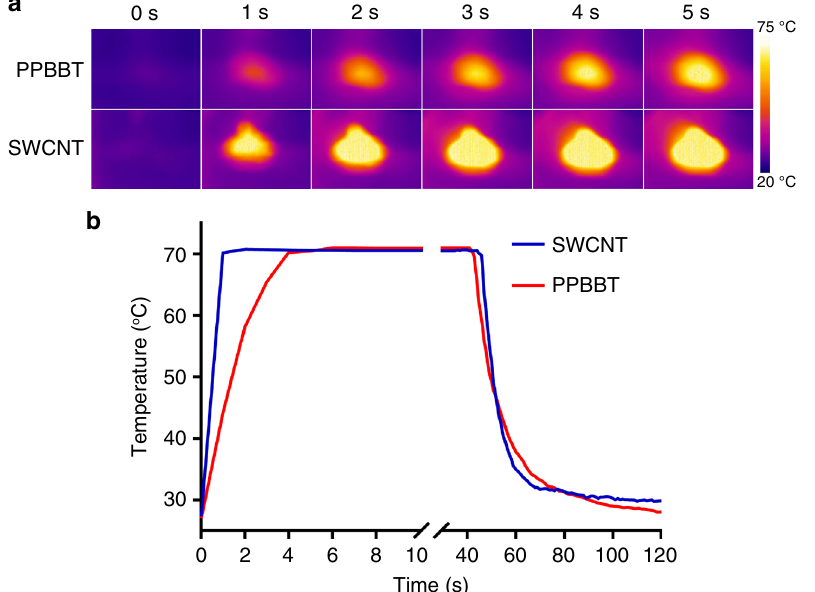
Fig. 2 Photothermal properties of PPBBT. a Time-dependent thermal images of 100 mg PPBBT and 100 mg SWCNT powders exposed to 0.8 W cm − 2 Xe light. b Temperature curve as a function of Xe lamp irradiation time in a. The light source was removed at about 40